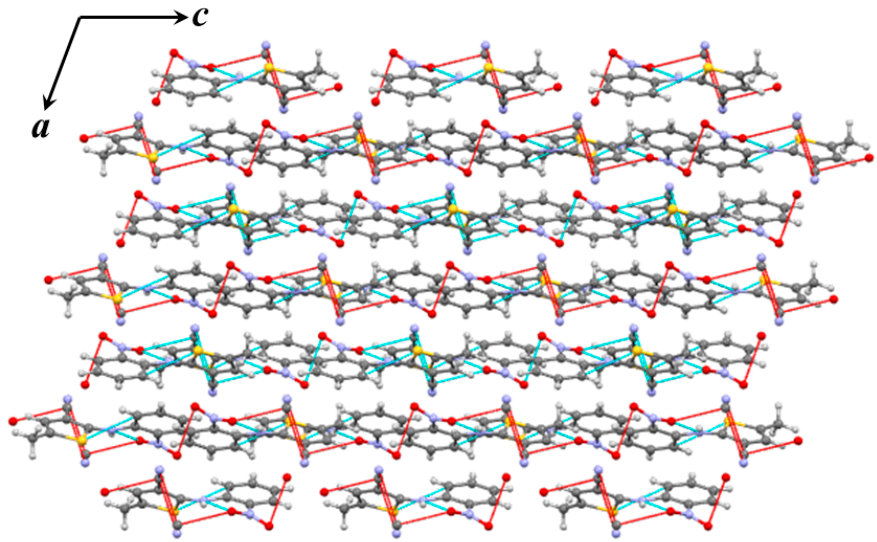
Figure 5. Crystal packing in polymorph OP showing hydrogen-bonded layers. Intermolecular (red lines) and intramolecular hydrogen bonds (teal lines) are shown.